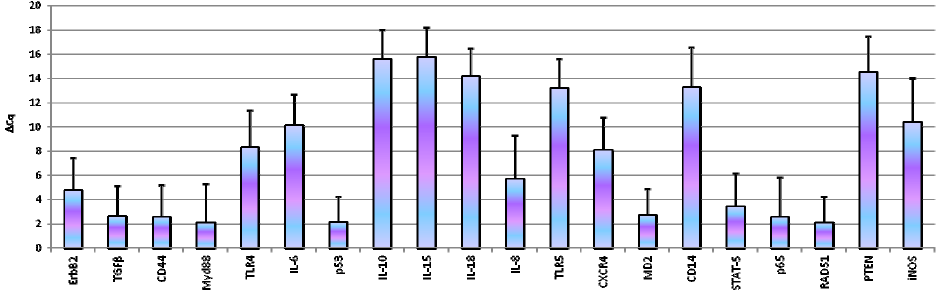
Figure 1. Basal gene expression in D-17 cells. Data are expressed as Δ Cq ± 1 standard deviation.